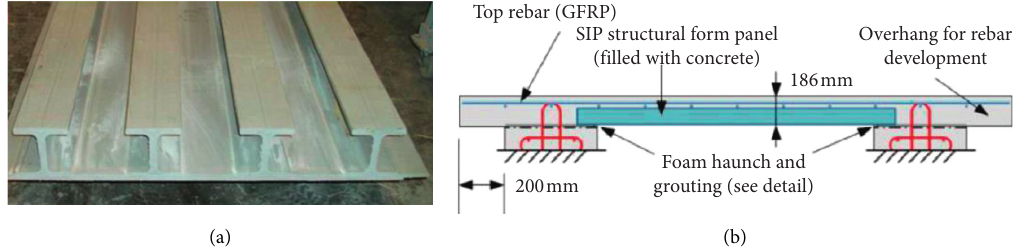
Figure 9: Hybrid deck system proposed by Nelson. (a) GFRP profiles. (b) Hybrid deck supported by precast concrete girders.